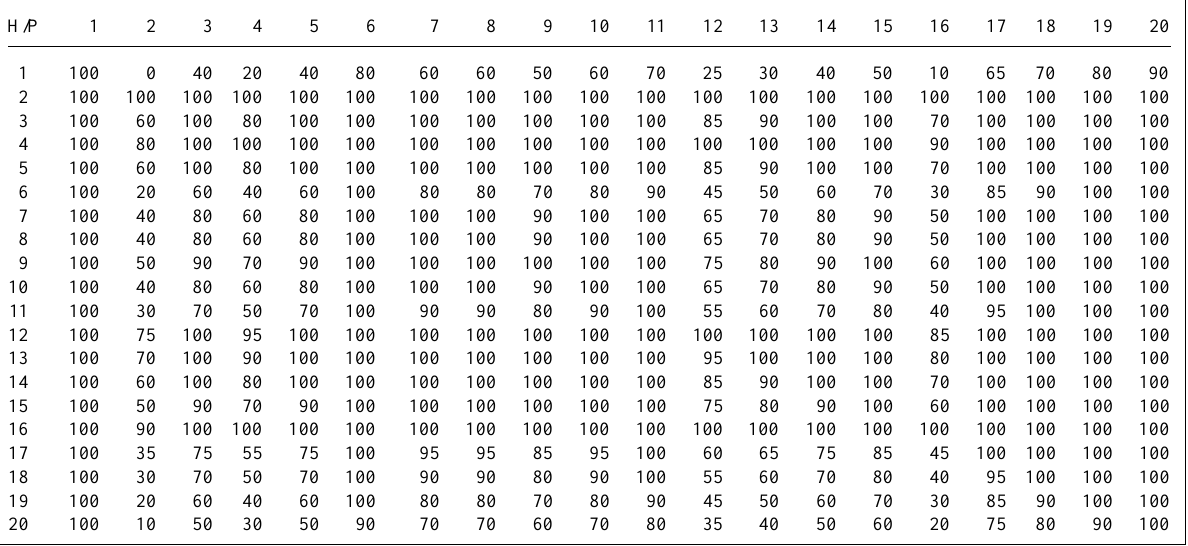
Table IV - Disease severity (%) of 20 hosts inoculated with 20 races of a pathogen, according to additive